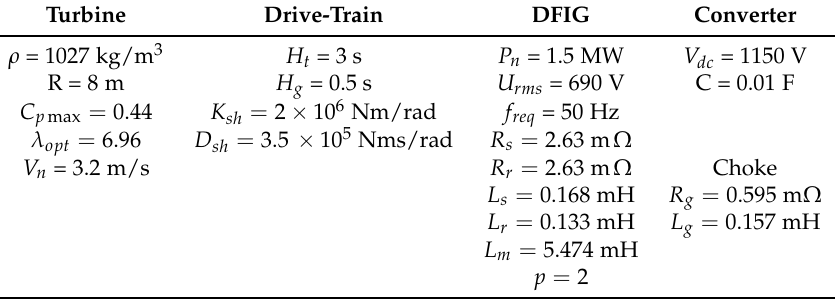
Table A2. TSG system